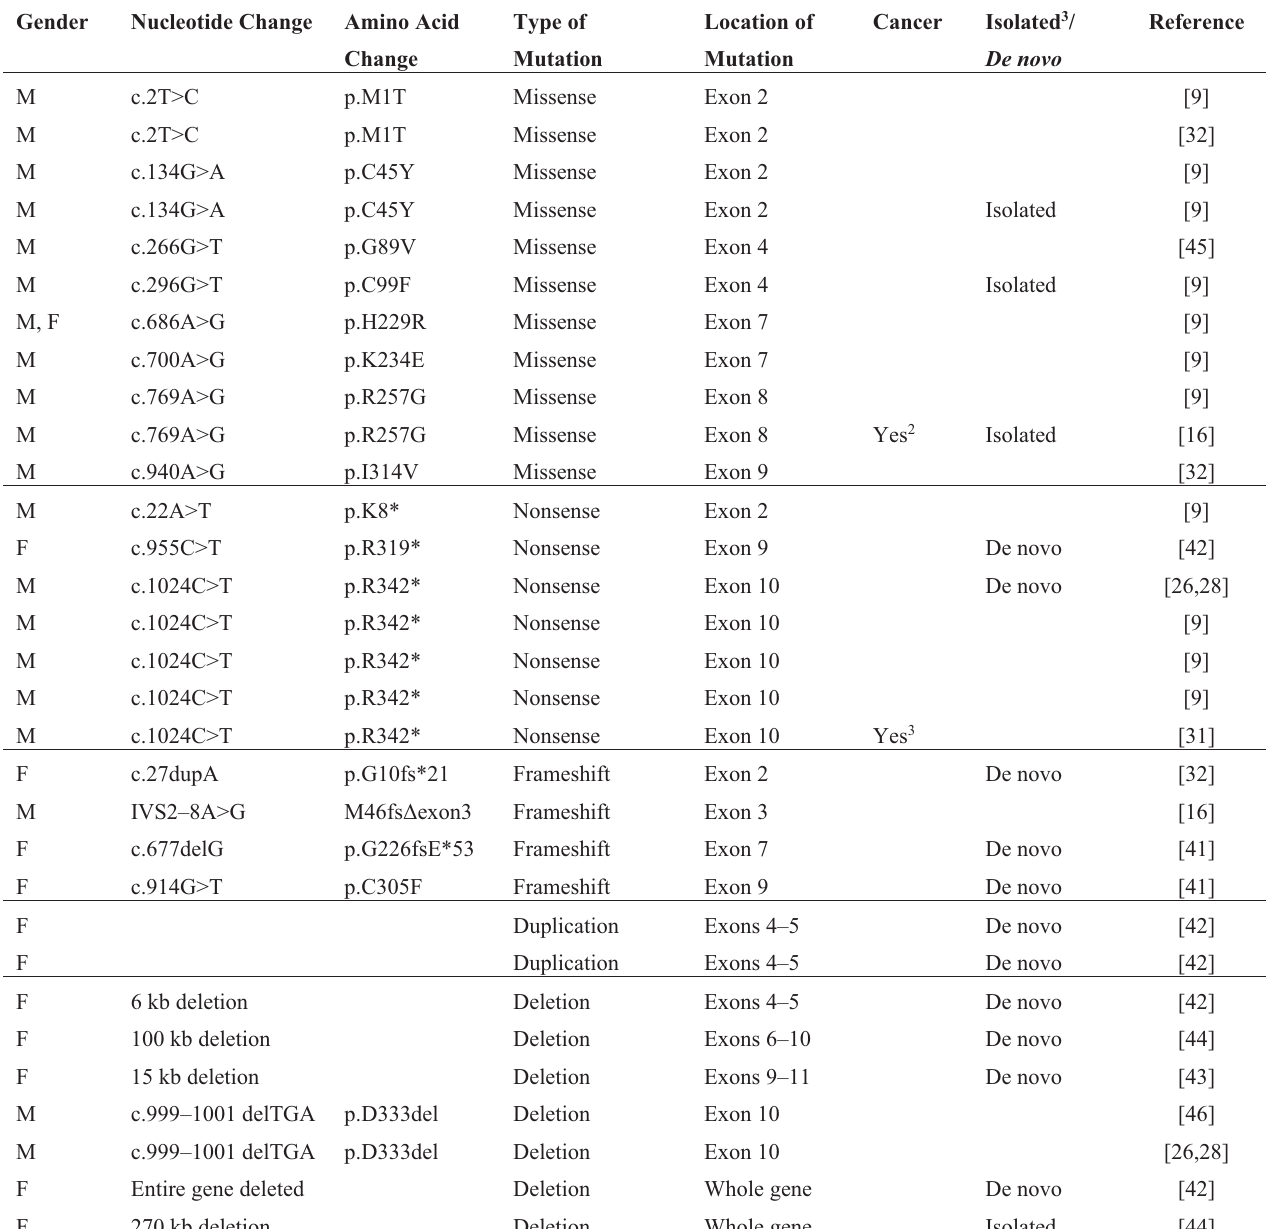
Table 1. Summary of germline PHF6